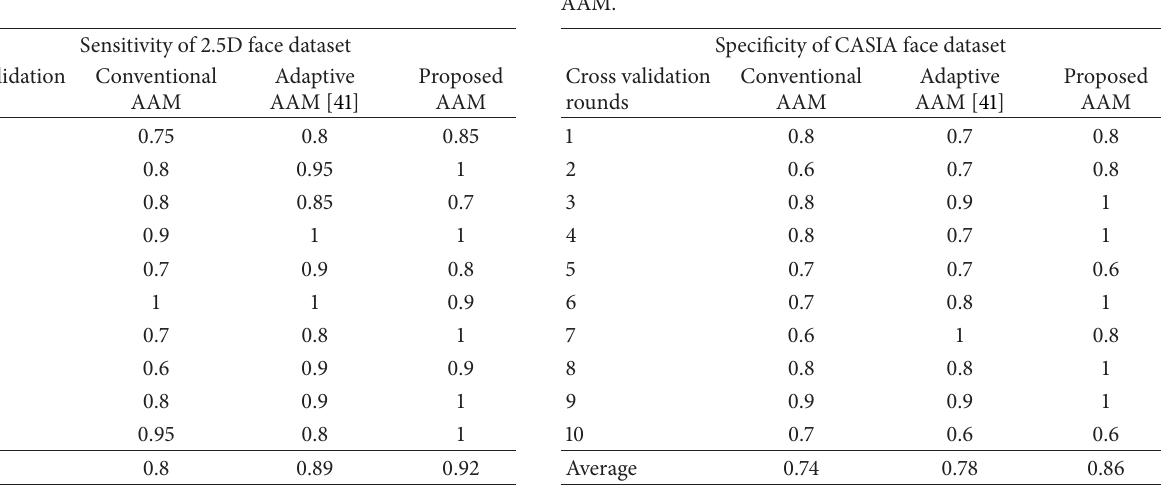
Table 7: Cross validation results for 2.5D face dataset in terms of sensitivity for conventional AAM, adaptive AAM, and the proposed AAM.